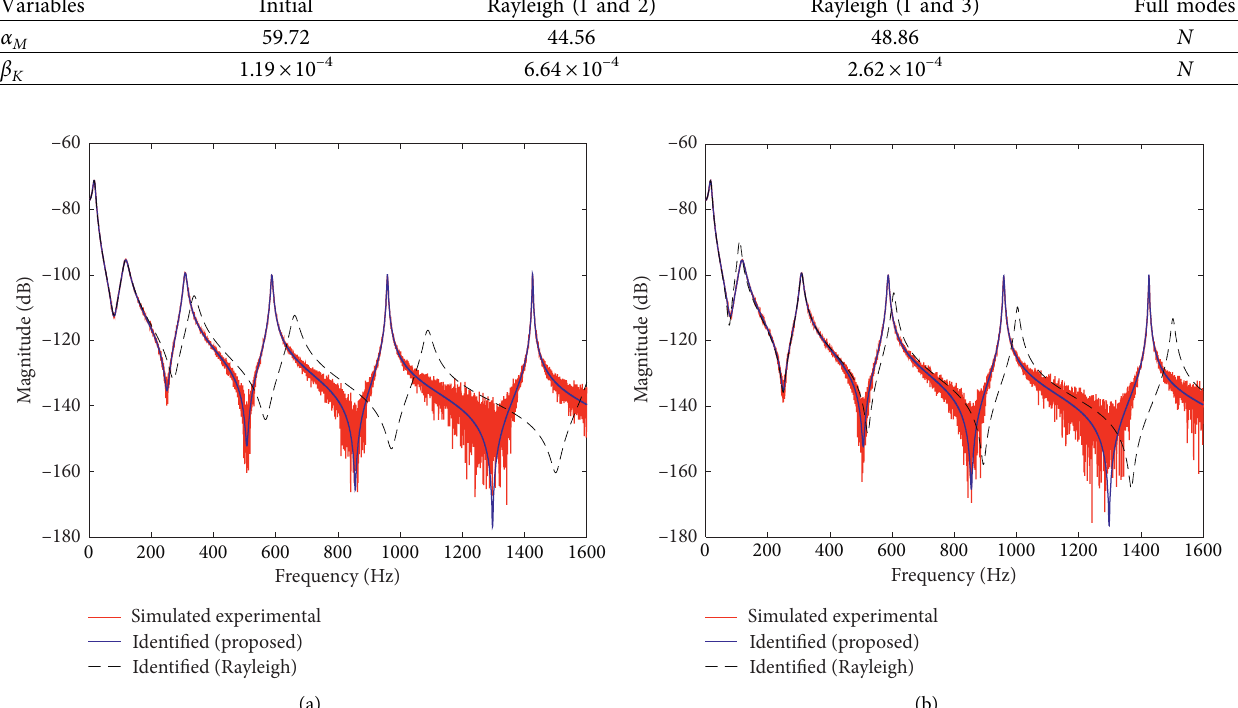
Figure 4: Comparison of simulated and updated analytical FRFs H